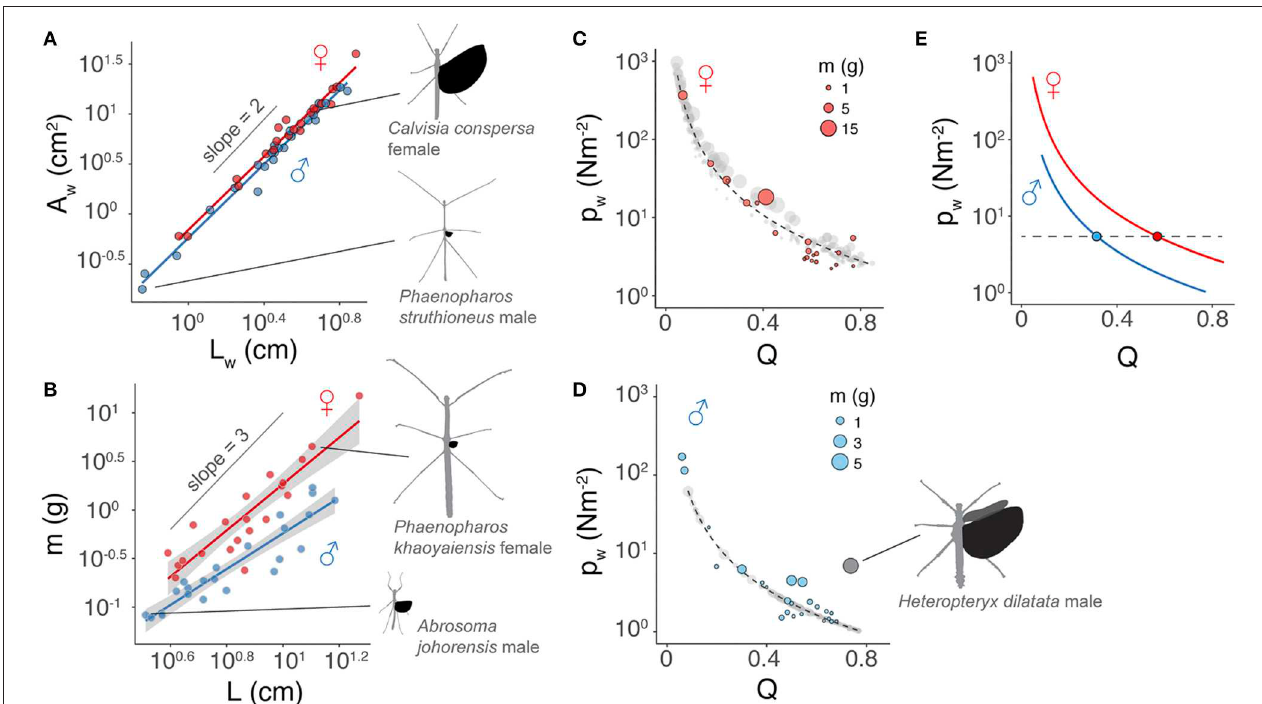
FIGURE 4 | Scaling of flight-related morphology. (A) Near-isometric scaling of wing area with relative wing size. Trend lines are based on linear regression models with slopes equal to 1.84 ± 0.05 and 1.84 ± 0.07 (mean ± s.e.m.) for males and females, respectively; R 2 = 0.98 and P < 0.0001 for both sex groups). (B) Allometric scaling of insect body mass with body length. Trend lines are based on linear regression models; Males: slope = 1.84 ± 0.16, R 2 = 0.86, P < 0.0001, females: slope = 2.39 ± 0.21, R 2 = 0.86, P < 0.0001. (C,D) Allometric scaling of wing loading (p w ) in females and males, respectively. Colored dots represent insects for which body mass and wing area were directly measured. Gray dots are estimates based on wing and body lengths using regression models (see Methods). Trendlines are based on a logistic fit. The regression model for males omitted Heteropteryx dilatata (dark gray dot; calculated with the total area of fore- and hindwings), which is a morphological outlier with well-developed forewings. (E) Comparison of the scaling of p w with respect to Q between two sexes, showing that disproportionally longer wings in females are required to attain wing loading equivalent to that of males.